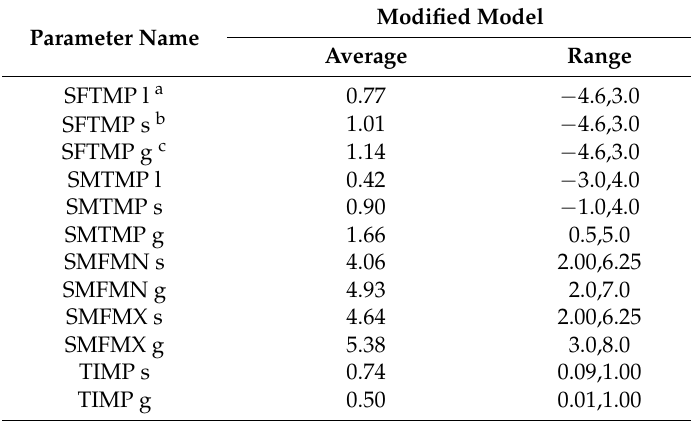
Table 7. Range and mean values of calibration parameters in subbasin-elevation band scale, Chile River